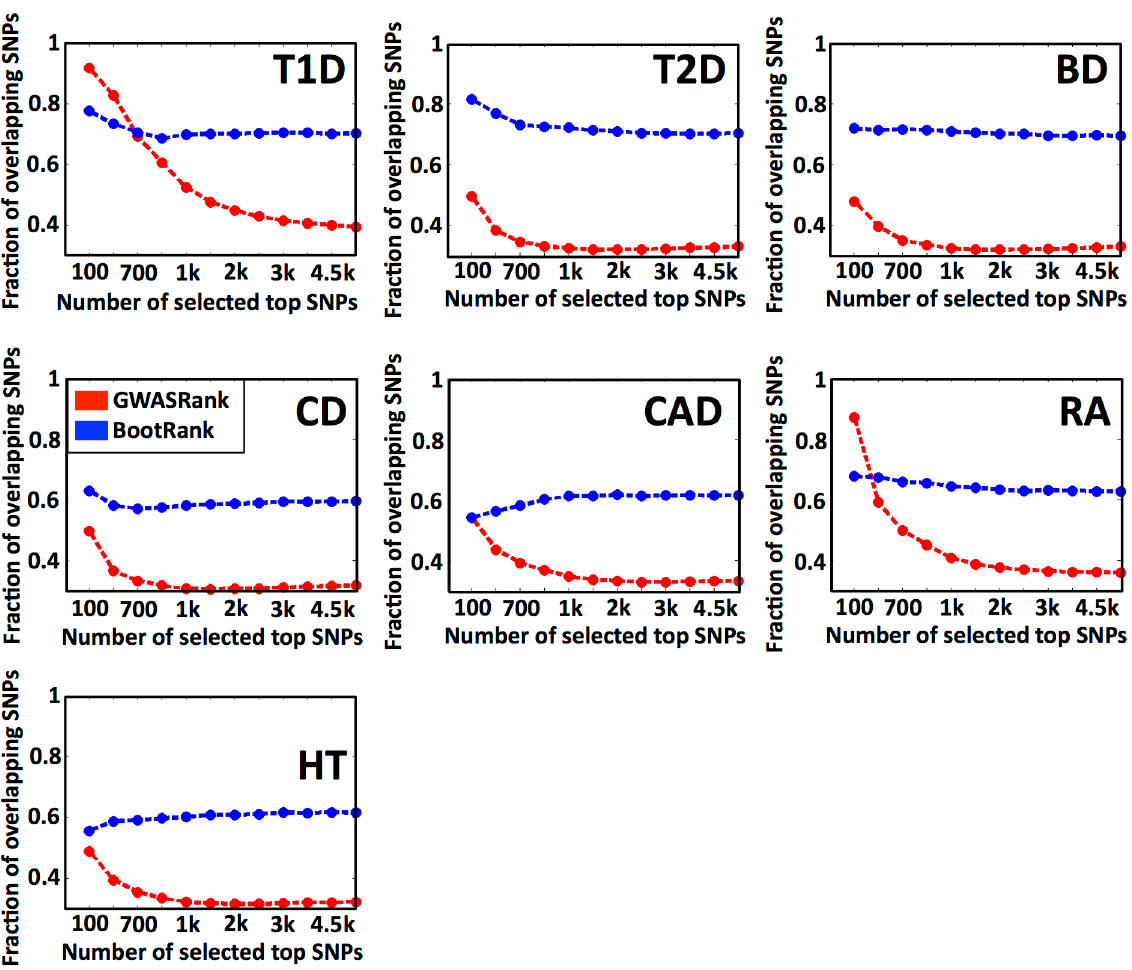
Figure 1. Fraction of intersection of filtered SNPs lists between different cross-validation partitions. For each disease (T1D, Type 1 diabetes; T2D, Type 2 diabetes; CD, Crohn’s disease; CAD, coronary artery disease; BD, bipolar disorder; RA, rheumatoid arthritis; HT, hypertension), shown is the mean fraction (y-axis) of top SNPs shared between training sets from different cross-validations when ranking SNPs by GWASRank (red) or BootRank (blue). The x-axis shows the number of SNPs that were selected as top SNPs from the SNP ranking.